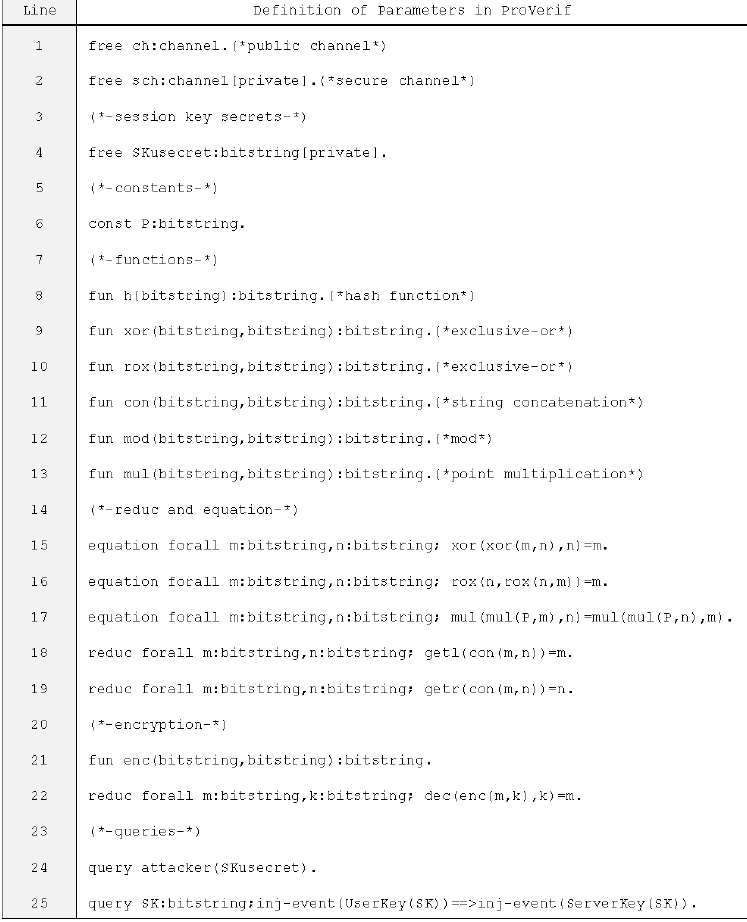
Figure 2. De fi nition of parameters in ProVerif. Figure 2. Definition of parameters in